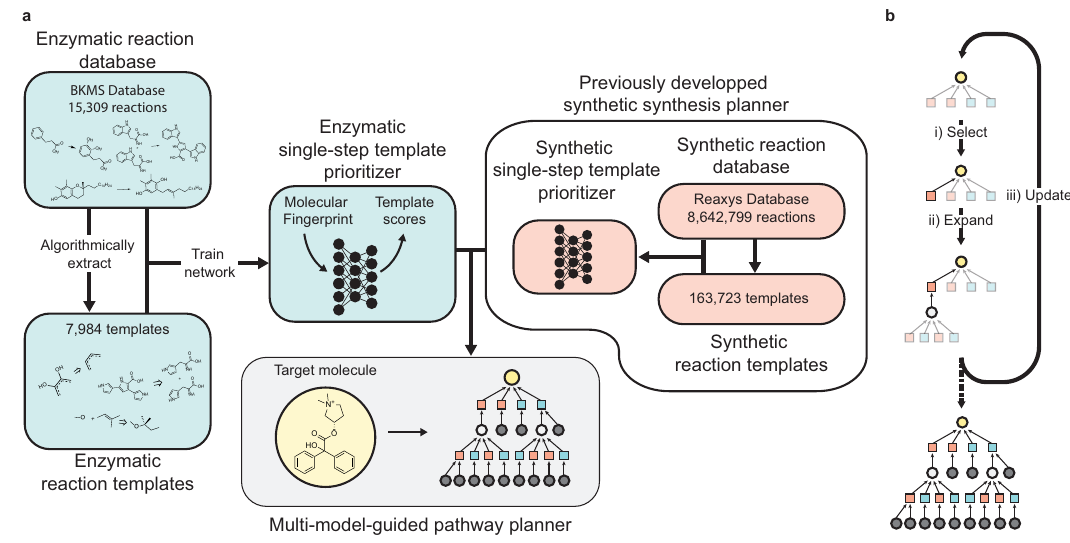
Fig.1|Machinelearningapproachtohybridsynthesisplanning.a Development work fl ow of the hybrid synthesis planner. A database of enzymatic reactions was parsed into machine-readable format. Reaction templates were algorithmically extracted from the reactions in the database. A neural network template prioritizer 47 was trained to predict the reaction template associated with each productmoleculeinthereactiondatabase.Theenzymatictemplateprioritizerand a previously trained synthetic template prioritizer 24 are used in tandem to predict hybrid synthesis plans. b Multi-model-guided tree search strategy used to explore the retrosynthetic search space for multi-step synthesis planning from an input molecule (yellow circle). The possible retrosynthetic reaction templates (squares)